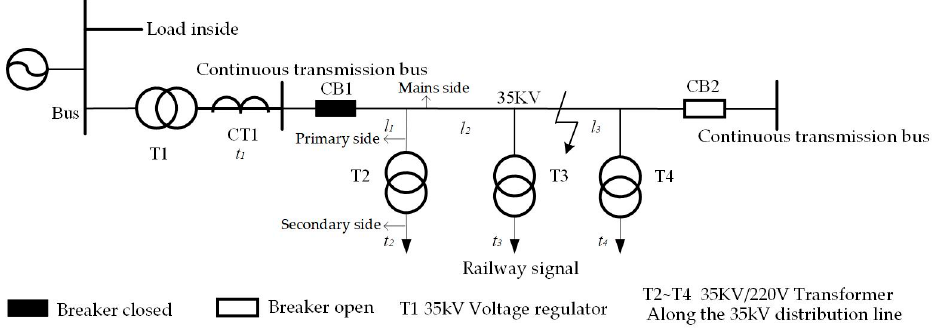
Figure 3. Diagram of continuous transmission lines.